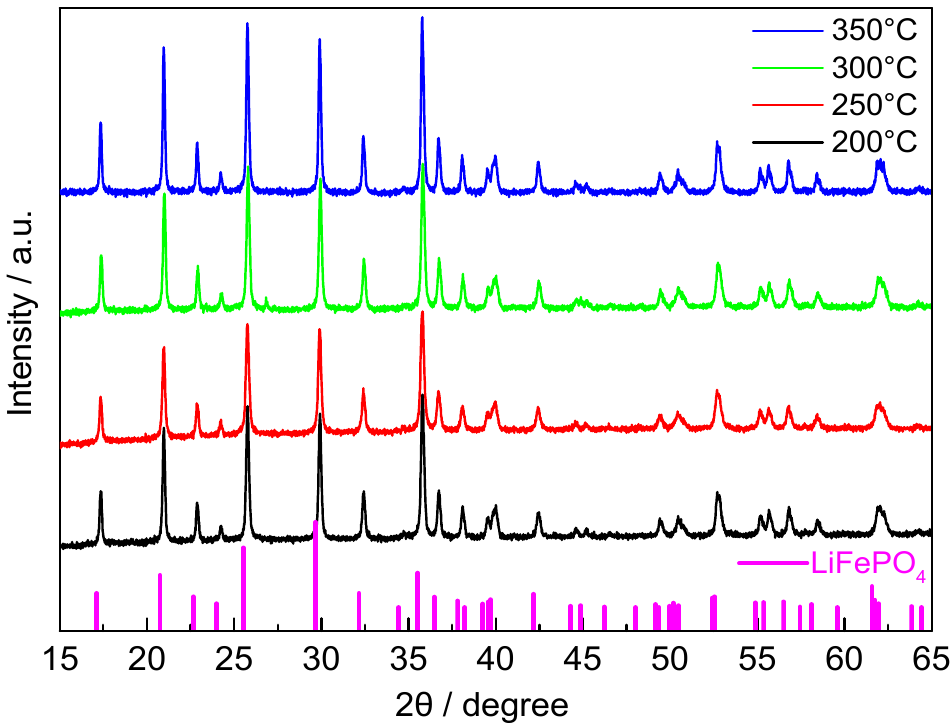
Figure 5. XRD patterns of LiFePO 4 samples prepared at spray drying temperature of 200 °C, 250 °C, 300 °C and 350